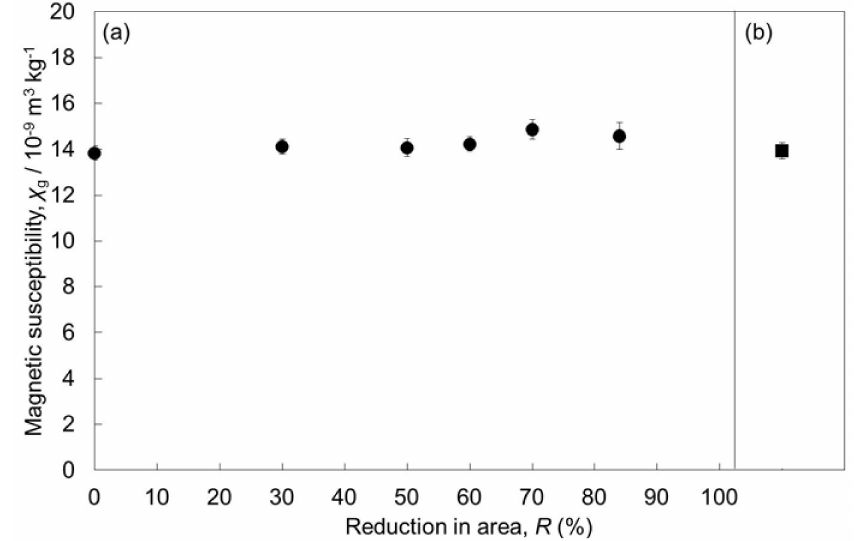
Figure 9. Magnetic susceptibilities of Zr–1Mo alloy specimens extracted ( a ) parallel to the processing direction, with area reductions of 0–84%, and ( b ) normal to the processing direction, with an area reduction of